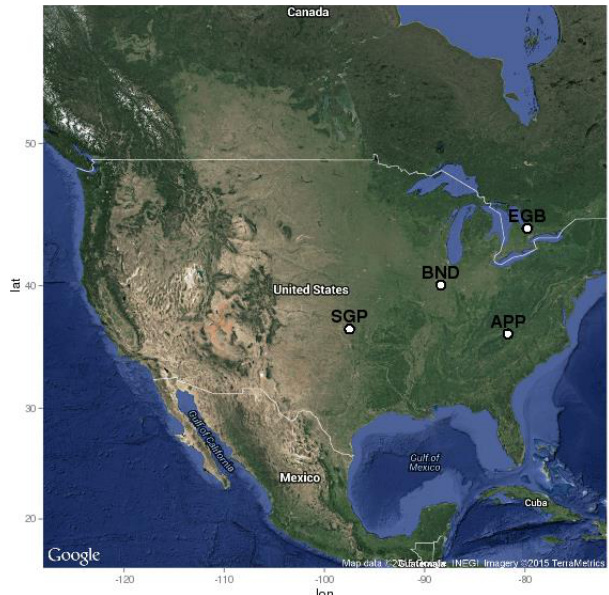
Figure 1. Locations of the four NOAA-ESRL sites in this study: Southern Great Plains, OK, (SGP); Bondville, IL (BND); Ap- palachian State (APP) in Boone, NC; and Egbert, Ontario, Canada